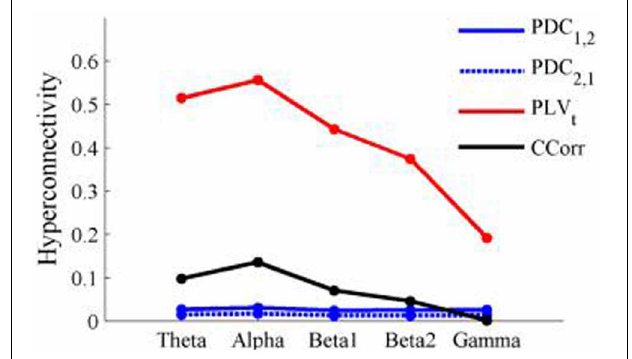
FIGURE 9 | Mean Hyperconnectivity values for time-averaged event-related EEG by connectivity measure and frequency band.